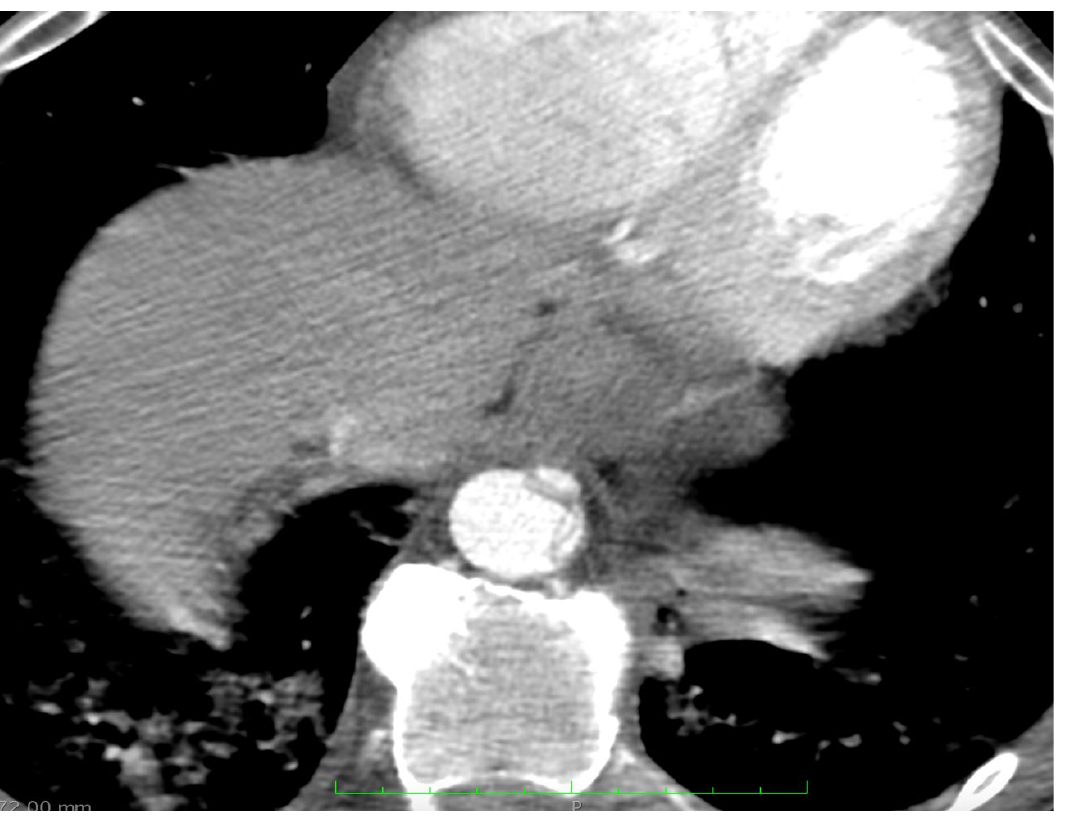
Figure 5. Small true lumen of the abdominal aorta at the origin of the celiac trunk, and protruding false lumen with a “double” intimal flap at this level.